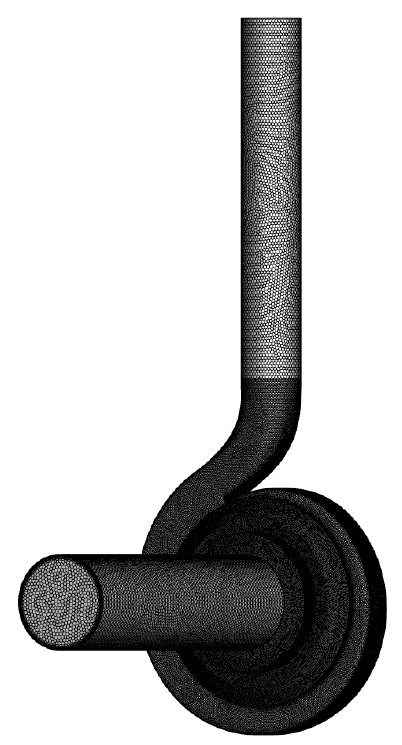
Figure 2. Unstructured grid division of centrifugal pump.